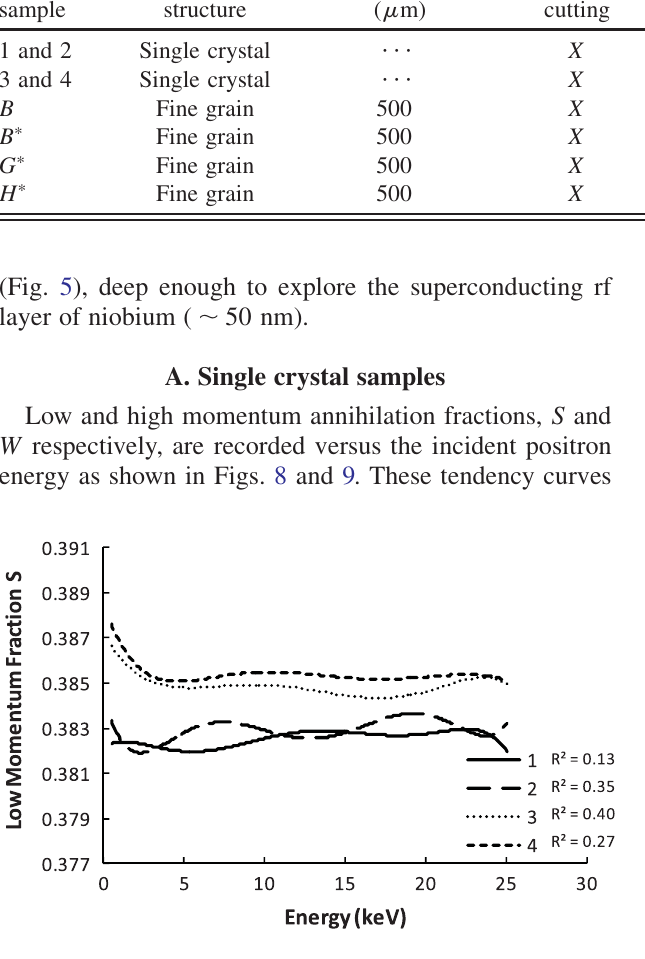
FIG. 8. Low momentum annihilation fraction S vs positron energy for unbaked (#1, #2) and baked (#3, #4) single crystal Nb samples.